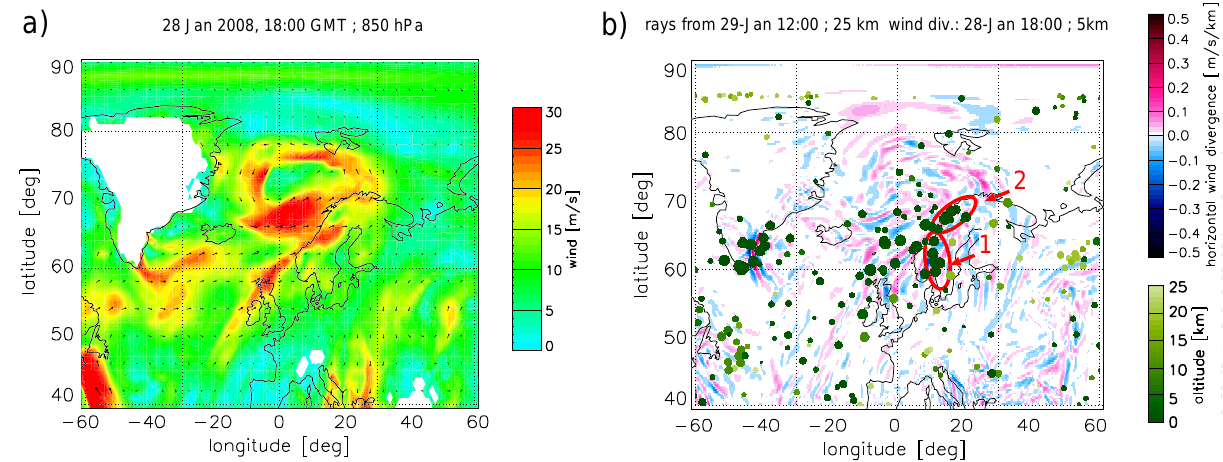
Figure 4. Absolute horizontal wind velocities (blue, 0ms − 1 to red, larger-equal 30ms − 1 ; arrows indicate direction) at 850hPa (a) for the North Atlantic. Values given are 18h prior to the GWMF analyses shown in Figs. 2 and 3 and display a storm approaching the Norwegian coast. Horizontal wind divergence (blue, − 0.5ms − 1 km − 1 to red, 0.5ms − 1 km − 1 ) for the same time (b) indicates GW activity at the south tip of Greenland, in the high-wind regions over the Northern Sea and for the southern part of Norway. The southern part of Norway is indicated by the red ellipse marked “1”. Also along the coast of mid Norway (red ellipse marked “2”) some wave structures are seen. These regions are source of strong GW activity at 25km, as indicated by the backtraces (altitude-colored dots; dark green, 0km to light-green, 25 km ).